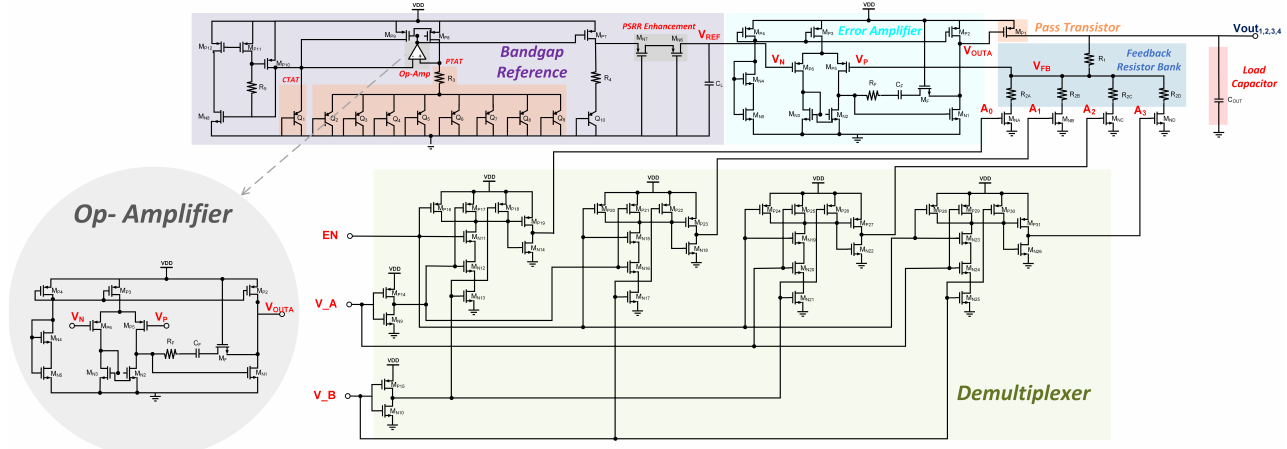
Figure 2. The circuit architecture of the